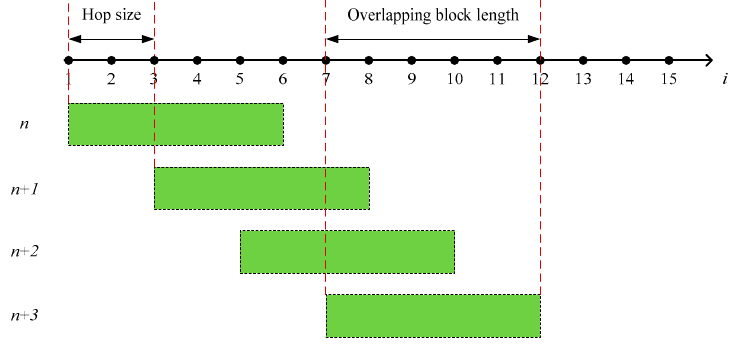
Figure 12. Schematic visualization of hop size and overlapping block length in STFT algorithm.